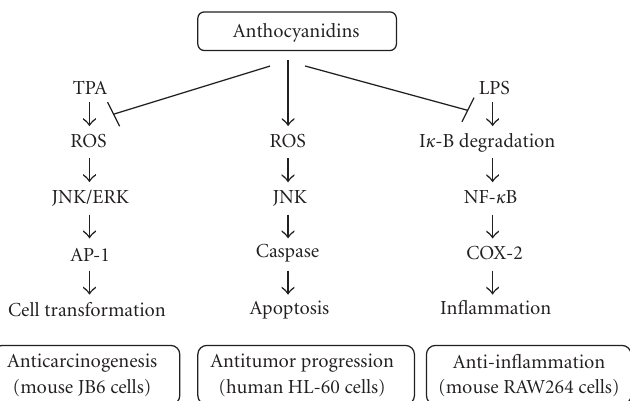
Figure 2. A schematic molecular view of cancer chemoprevention by anthocyanidins. Anthocyanidins may contribute to cancer chemoprevention through targeting three di ff erent signal transduction pathways and downstream genes. Abbreviations: AP-1, activa- tor protein-1; ERK, extracellular signal-regulated kinase; JNK, c-Jun NH 2 -terminal kinase; LPS, lipopolysaccharide; NF- κ B, nuclear factor κ B; ROS, reactive oxygen species; TPA, 12- O -tetradecanoylphorbol-13-acetate.